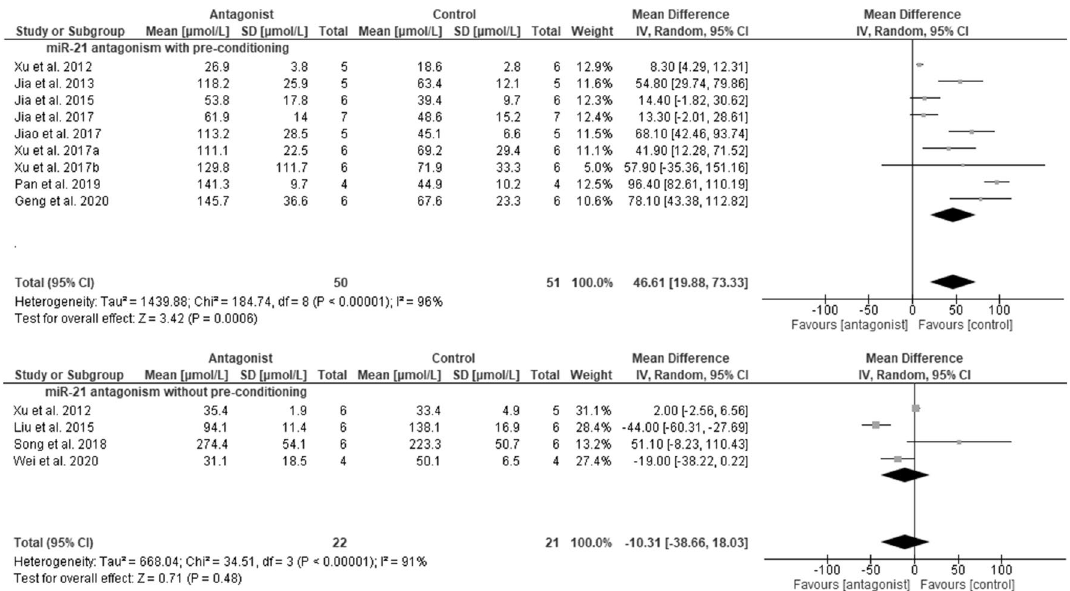
Figure 4. Meta-analyses of miRNA-21 antagonism on serum creatinine in AKI models (in the presence or absence of pre-conditioning). SD, standard deviation; CI, confidence